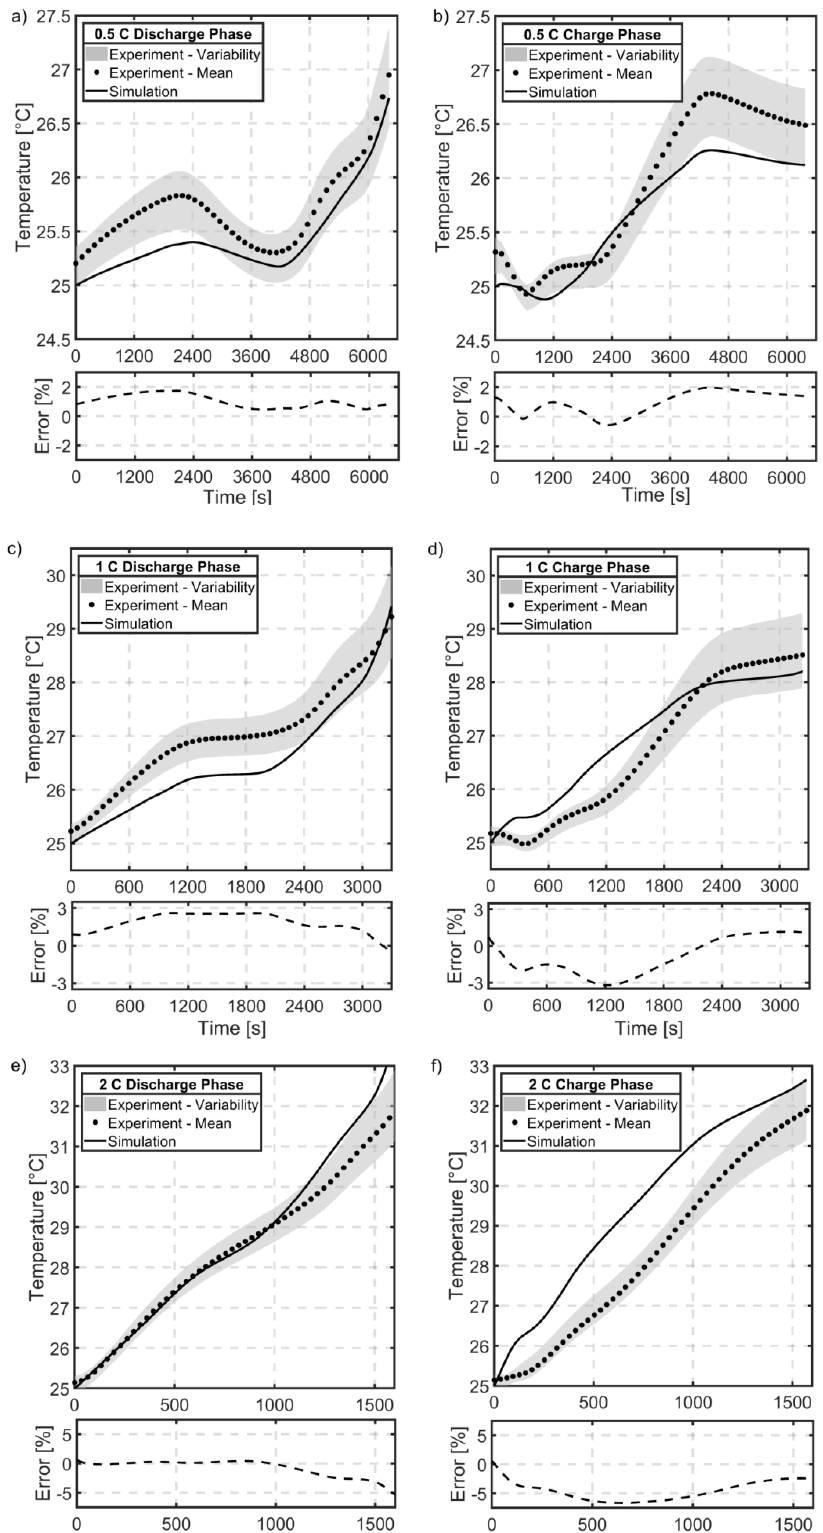
Figure 7. Experimental and simulated cell temperature profiles ( °C ) of the cell as a function of time (s) during a discharge and charge phase at: ( a , b ) 0.5 C, ( c , d ) 1 C, and ( e , f ) 2 C current rates. The cells were initially kept at a constant temperature of 25 °C for multiple hours in a fully charged/fully discharged state.